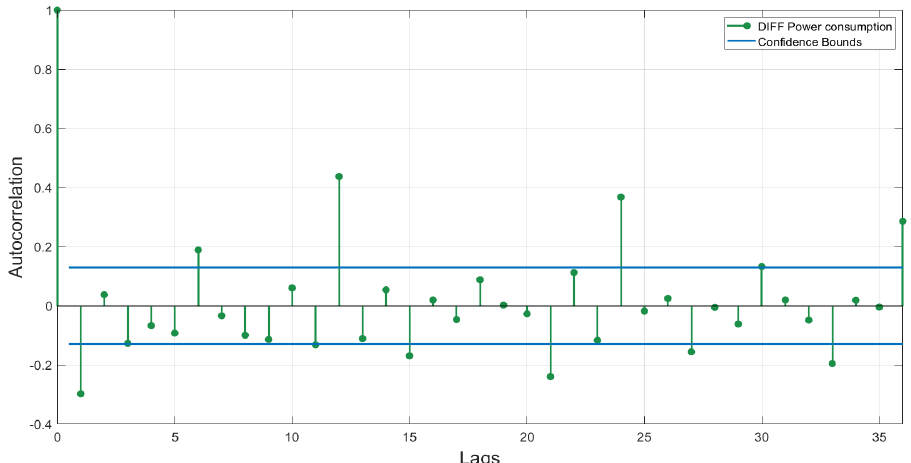
Figure 4. Auto-correlation for Diff Data for Monthly power consumption in Quito, Ecuador between January 1999 and December 2018.